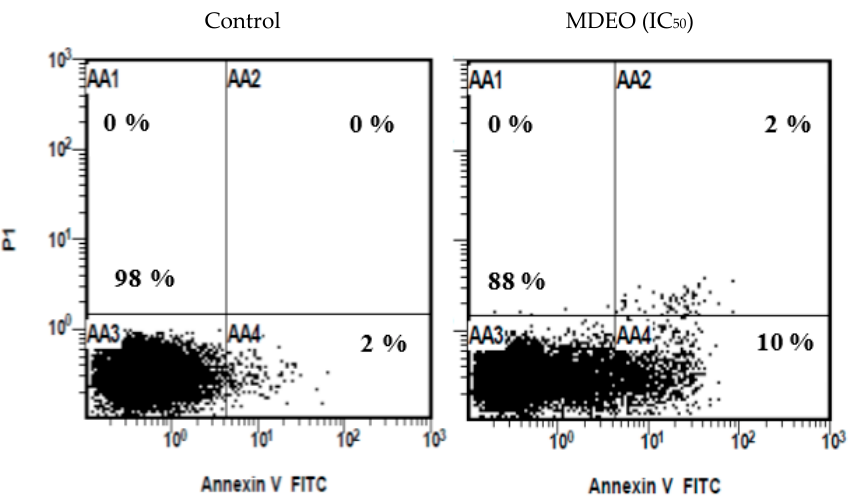
Figure 4. MDEO induces apoptosis in MCF-7 cells. AA1, AA2, AA3, and AA4 indicate the percentage of dead, late apoptotic, live, and early apoptotic cells, respectively.